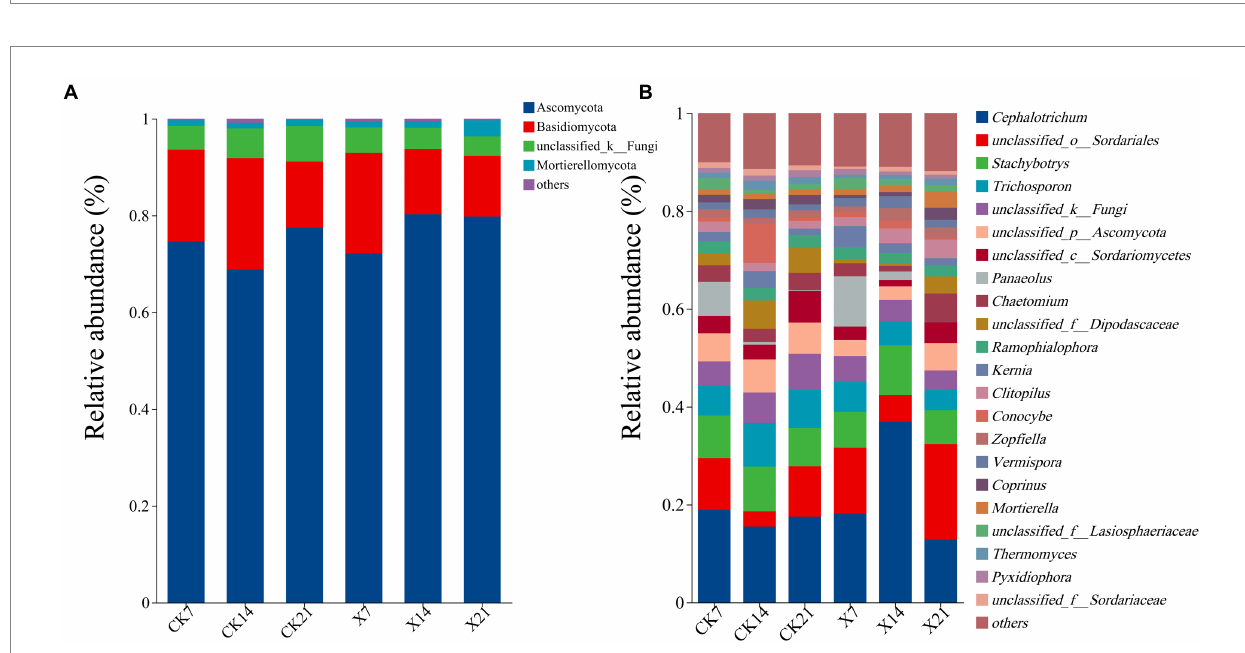
FIGURE 7 Fungal flora composition at phylum and genus levels. (A) Phylum level. (B) Genus level, genera with relative abundance less than 1% are classified as other. X refers to C. cateniannulata X8 treatment, CK refers to the control, and the number indicates the time point after